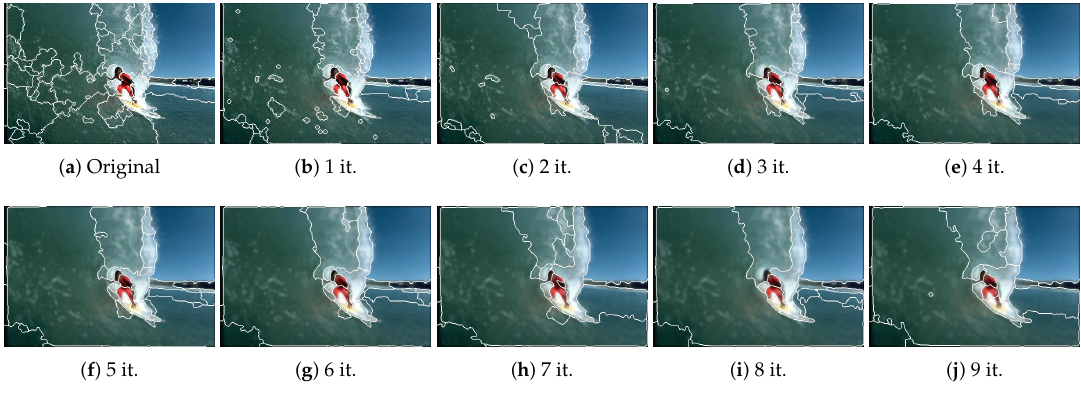
Figure 9. The evolution of the number of QFZs ( a ) and JSEG segments ( b ) as a function of the number of iterations of the Gaussian filter, for the eight images in Figure 2.